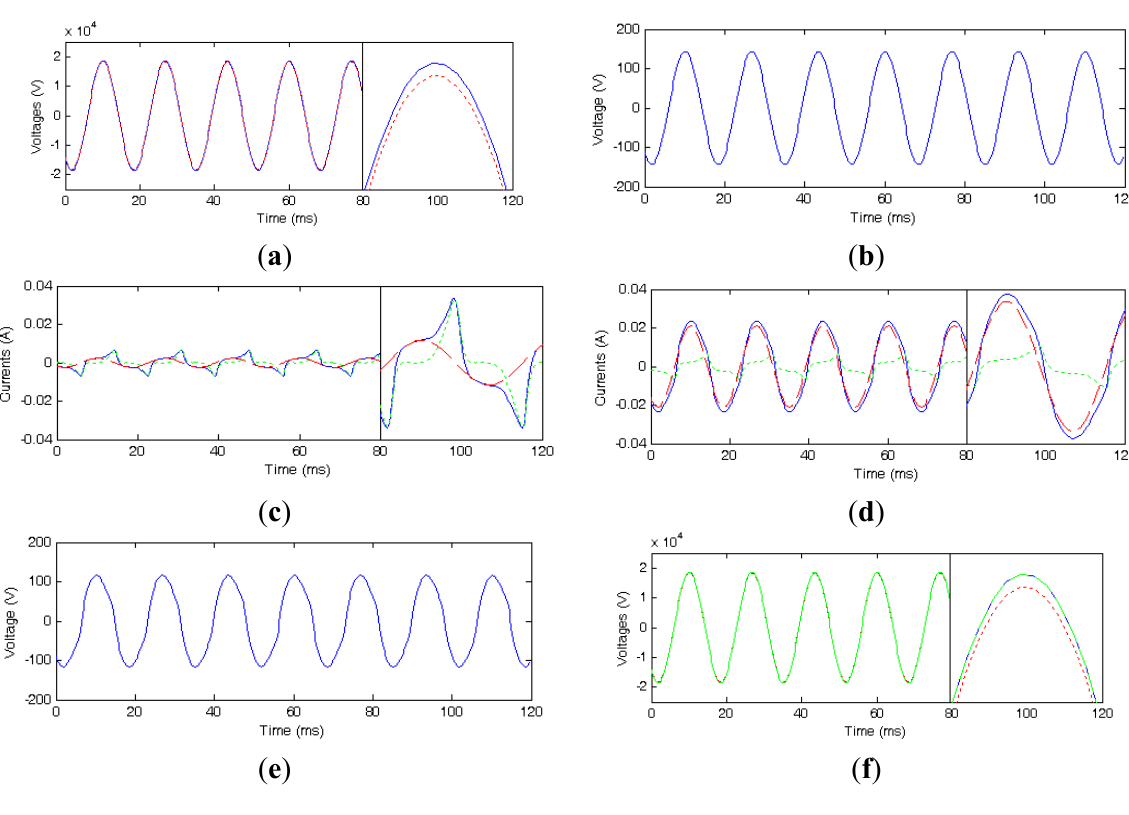
Figure 8. Results for Case 2: ( a ) v 1 (solid) and av 2 (dotted); ( b ) av s ; ( c ) i 0 (solid), i m (dotted), and i c (dashed); ( d ) i 1 (solid), i 0 (dotted), and i 2 /a (dashed); ( e ) v p ; and ( f ) v 1 (solid), av 2 (dotted), and v comp (dashed). Table 3. Errors for 100% of the rated